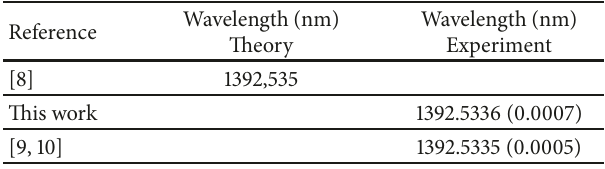
Table 1: Some wavelength values associated with the 1392.53 nm absorption line of water vapour at ambient